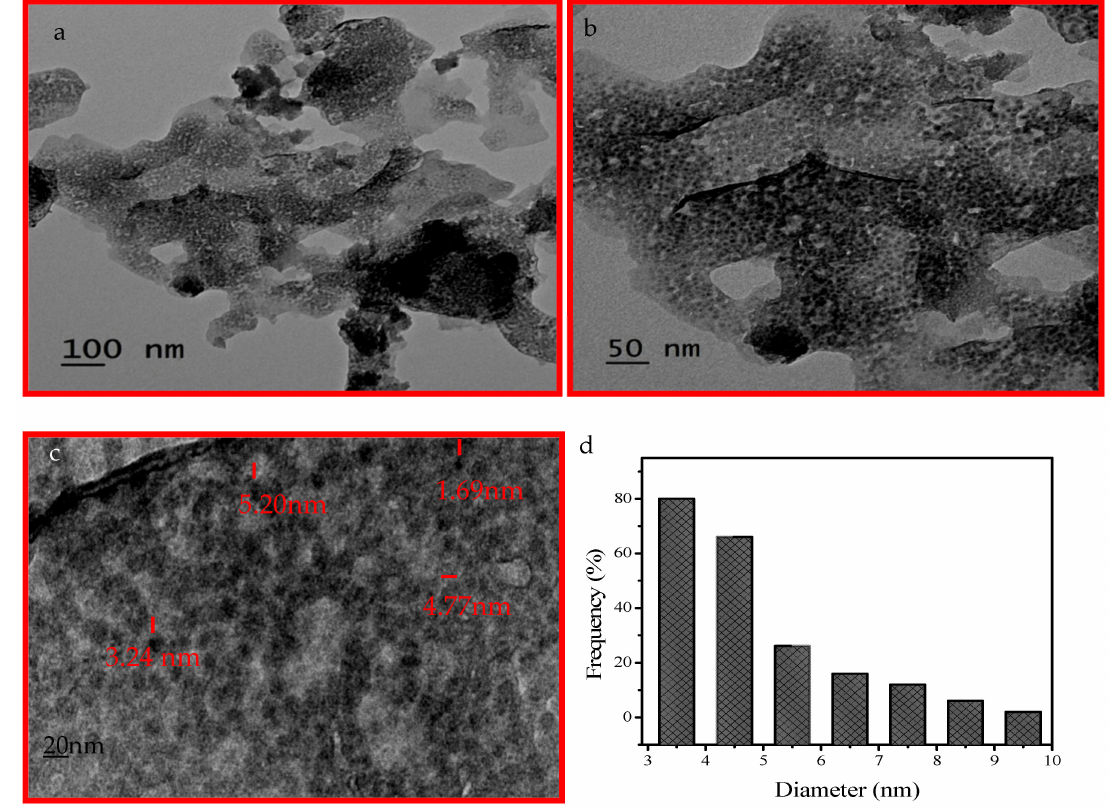
Figure 1. ( a – c ) TEM images, ( d ) distribution of particle sizes Mn 2+ :ZnS